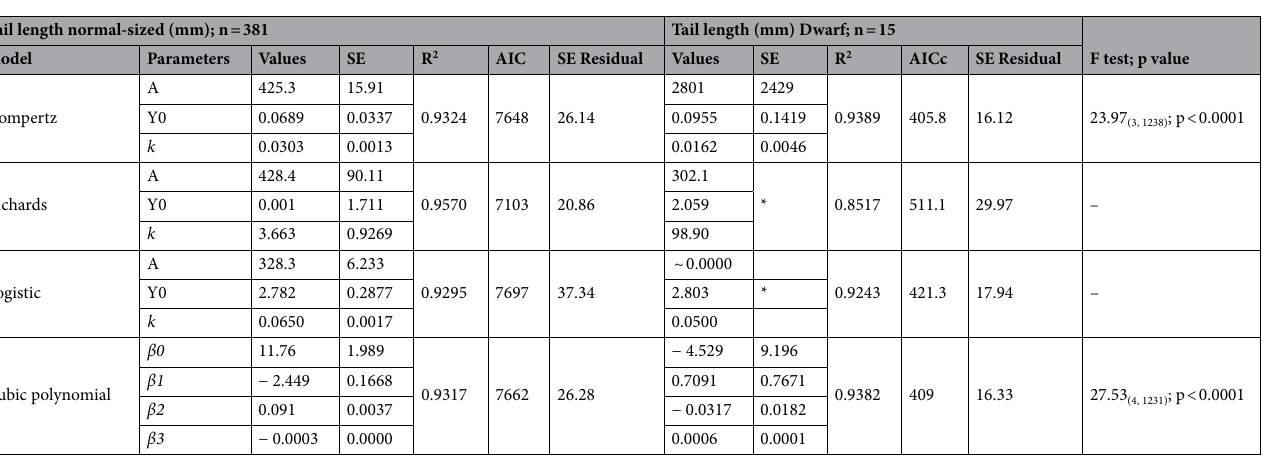
Table 3. Results from four models fitted to tail length growth to normal-sized and dwarfs hyacinth macaw. Parameters of the Gompertz, Richards and Logistic models: A upper asymptote (i.e. predicted adult size), k maximum relative growth rate, Y0 initial value of the asymptotic curve. Cubic polynomial models are represented with four parameters: β0 intercept, β1 maximum relative growth rate, β2 upper asymptote, β3 weight loss begins. *Very wide confidence interval = CI >